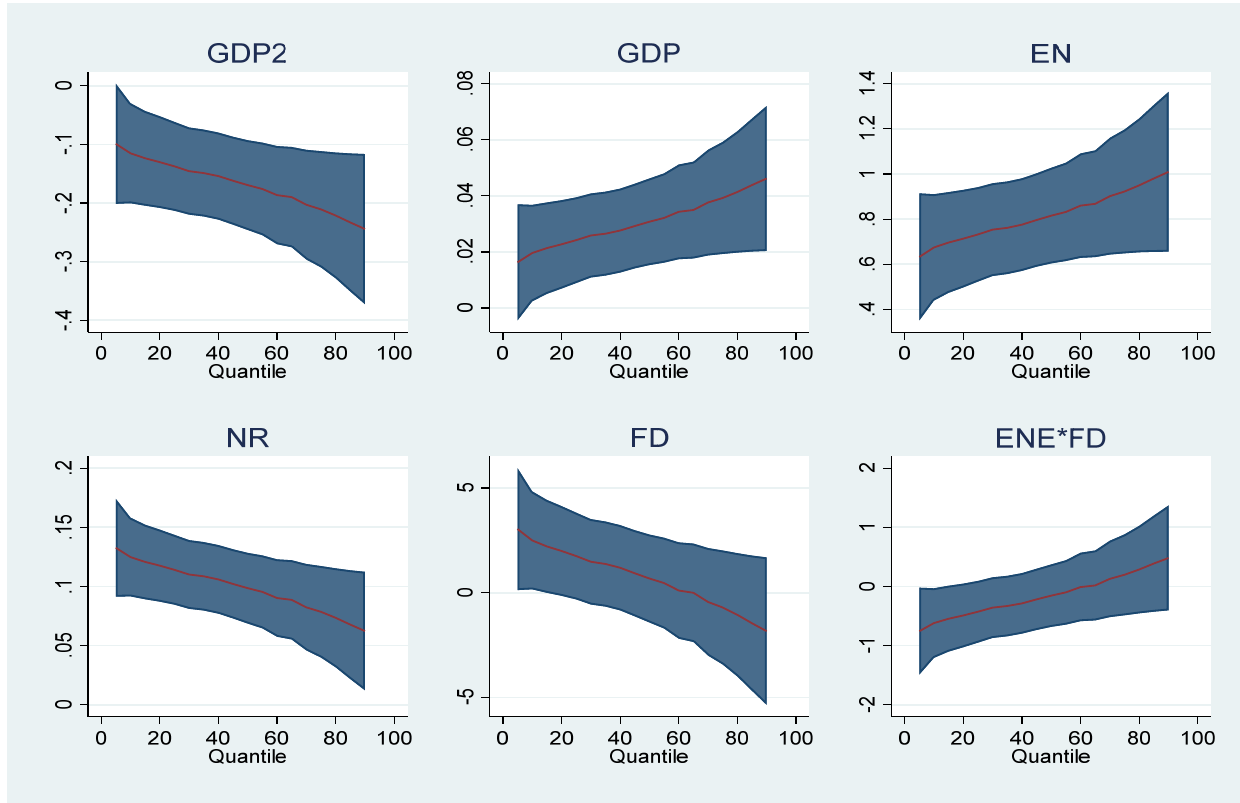
Figure 1. Plots for MMQR estimates. Table 6. MMQR estimation report.